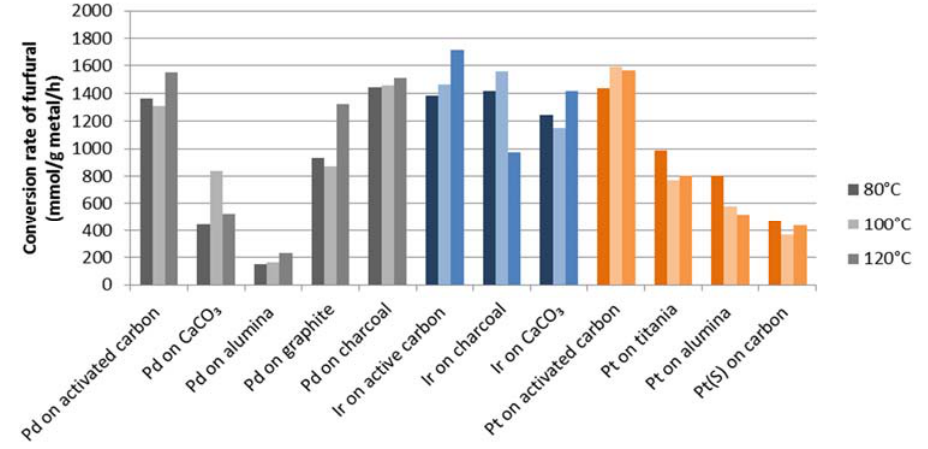
Figure 2. Conversion rate of furfural (mmol/g metal/h) for noble metals at 5% w / w metal loading.